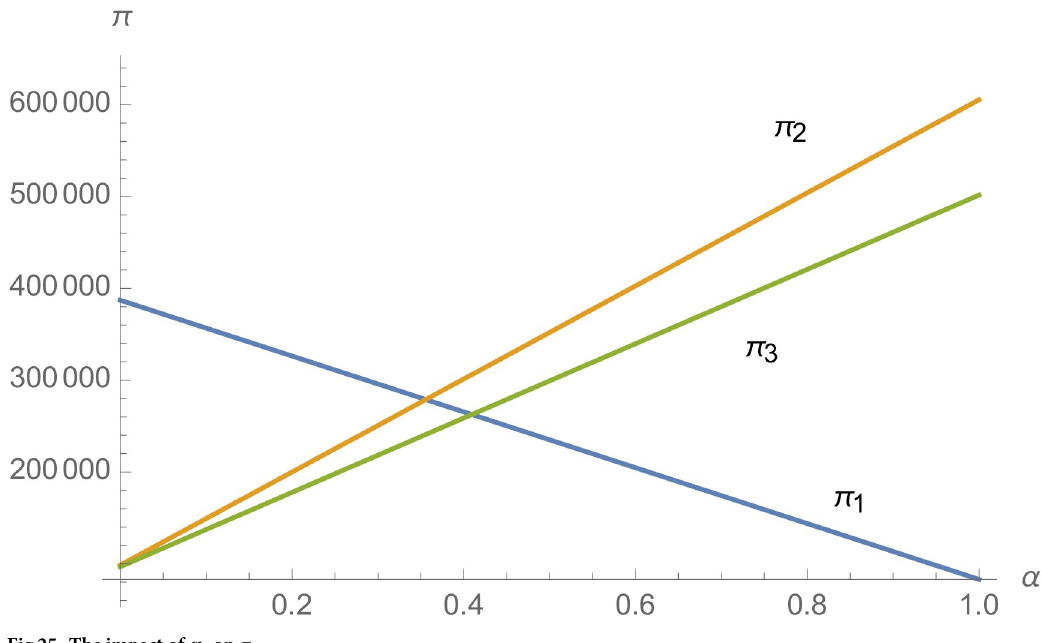
Fig 25. The impact of α 1 on π